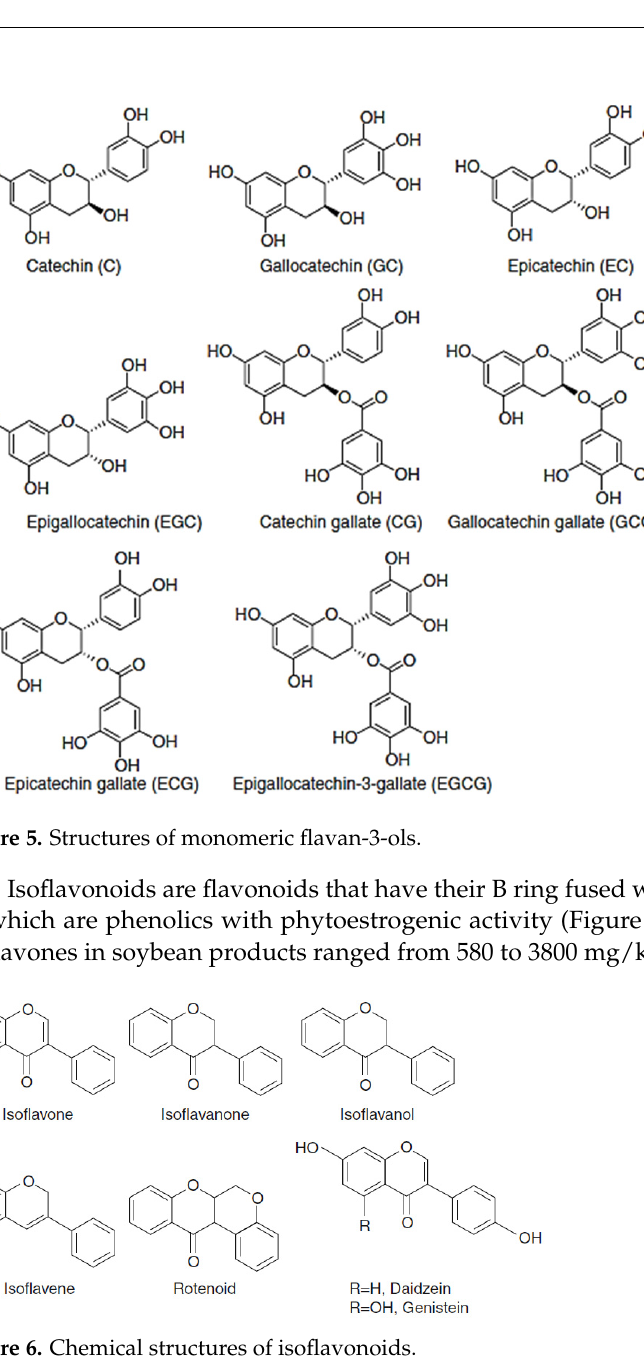
Figure 13 . Chemical structure of 3-butylphthalide.